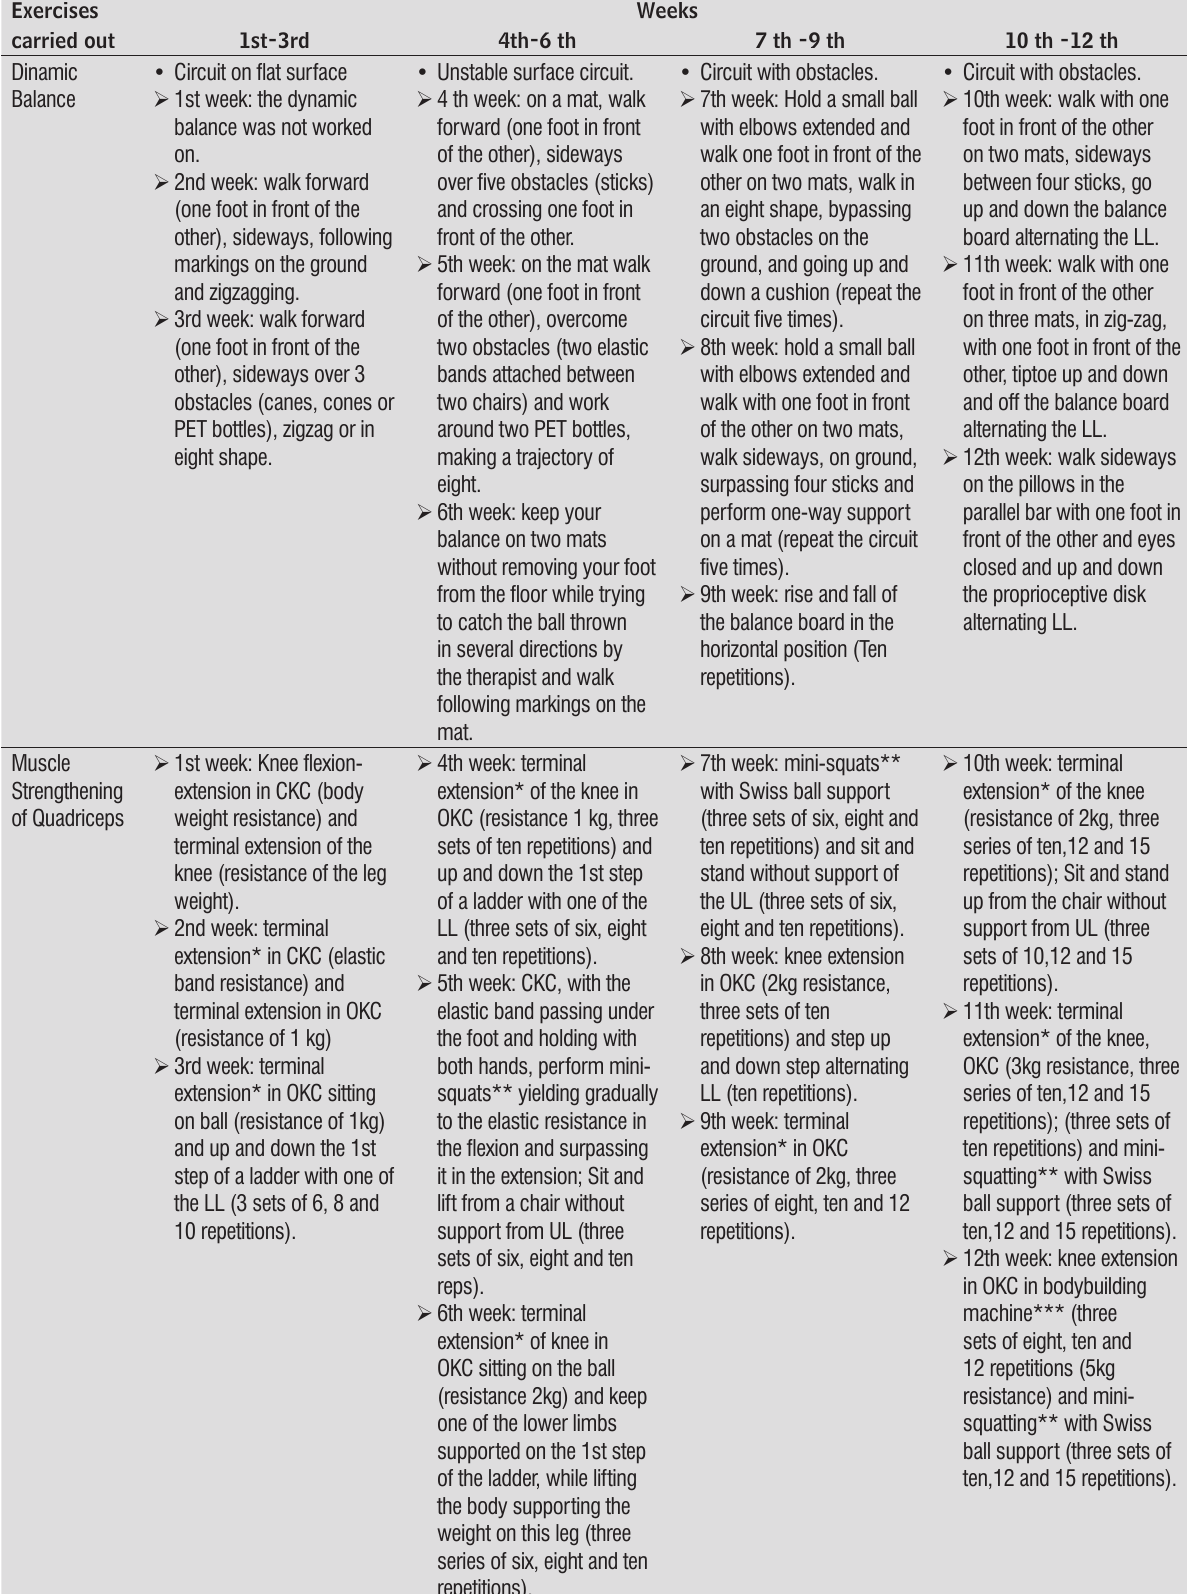
Table 1 - Progression of exercises at 12 weeks of treatment